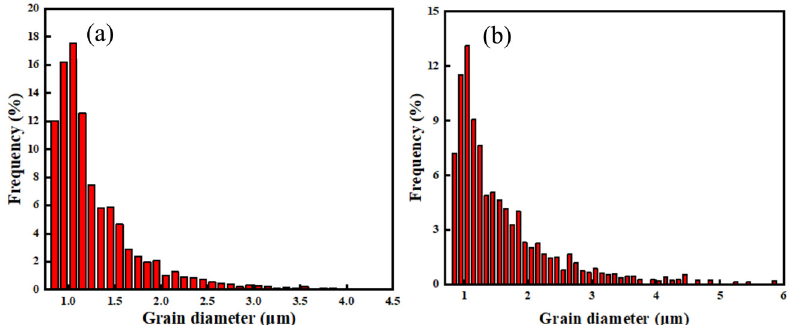
Figure 12. Comparison of grain sizes: ( a ) flux-cored wire welding joint; ( b ) cable wire welding joint.